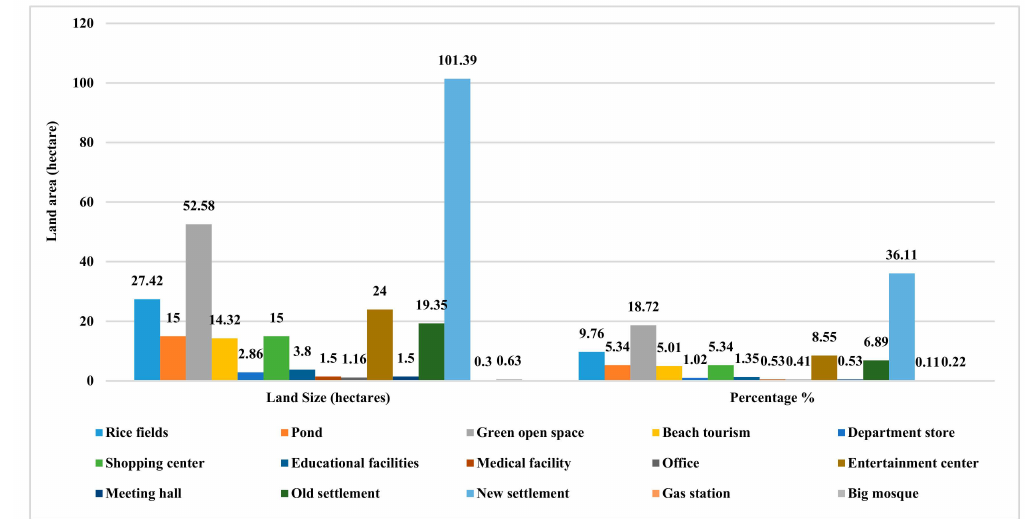
Figure 9. Utilization of space in the new city area of Metro Tanjung Bunga in the period 2010–2013. Source: Field Observation Results and Google Maps @